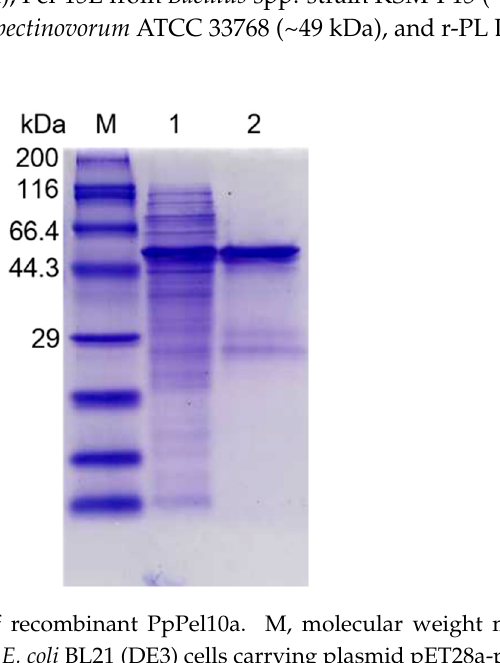
Table 2. Purification of P. polymyxa KF-1 Pel10a and of recombinant PpPel10a from E. coli .